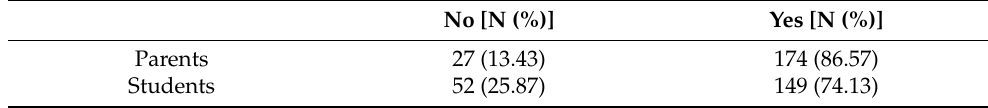
Table 4. COVID-19 vaccination